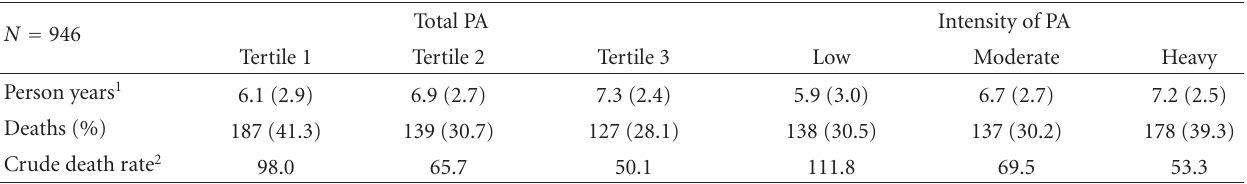
Per 1000 person